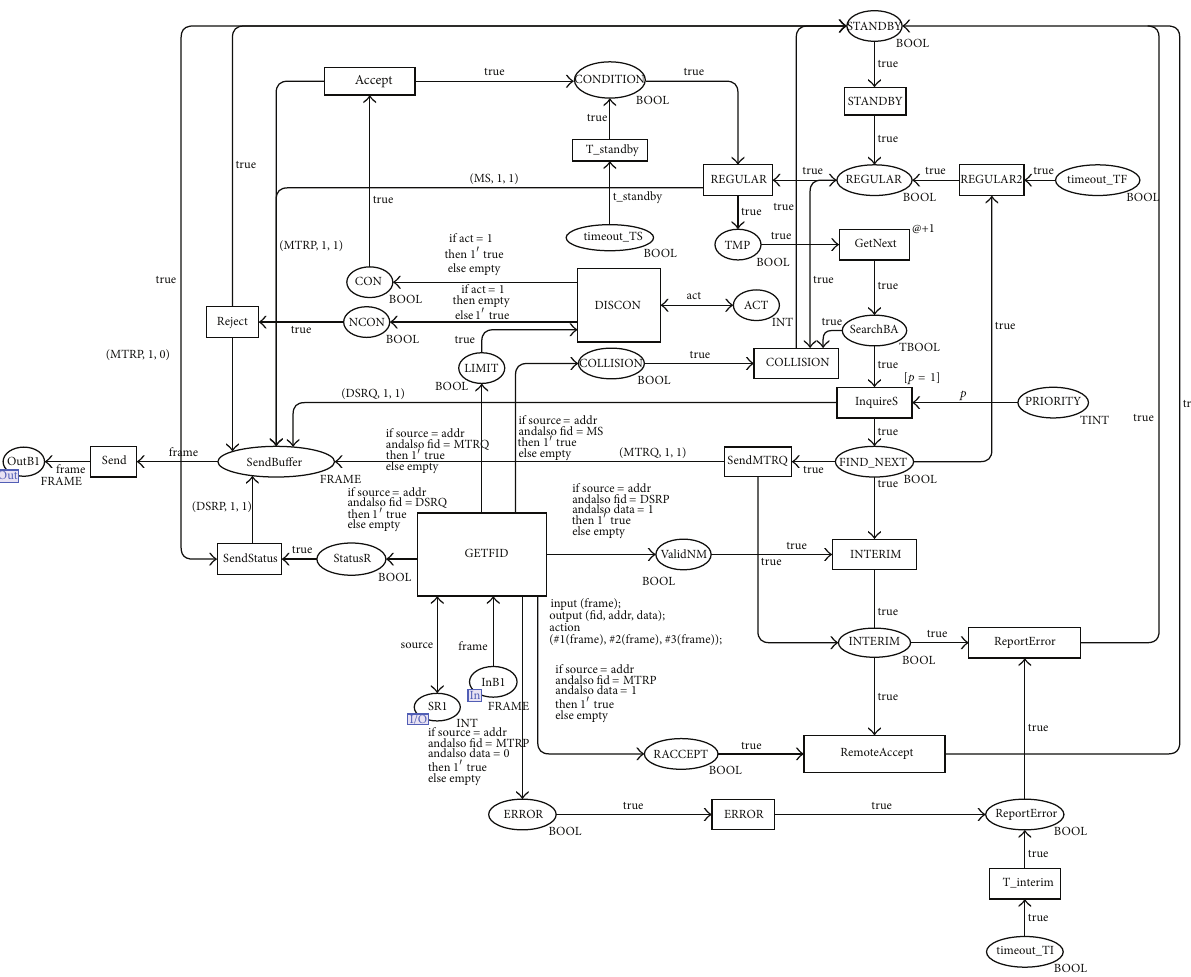
Figure 7: BusAdmin1